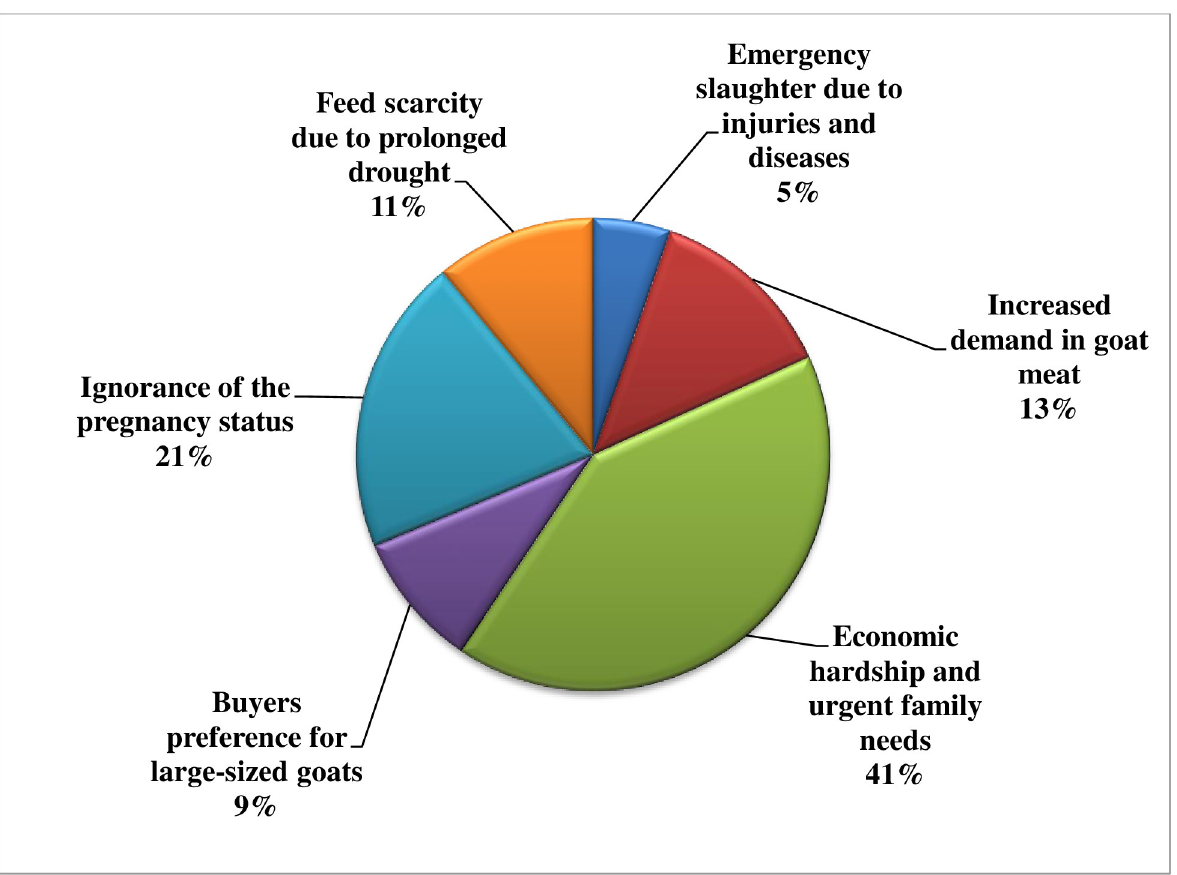
Fig 1. Reasons advanced for sale or slaughter of pregnant goats for meat in Enugu,